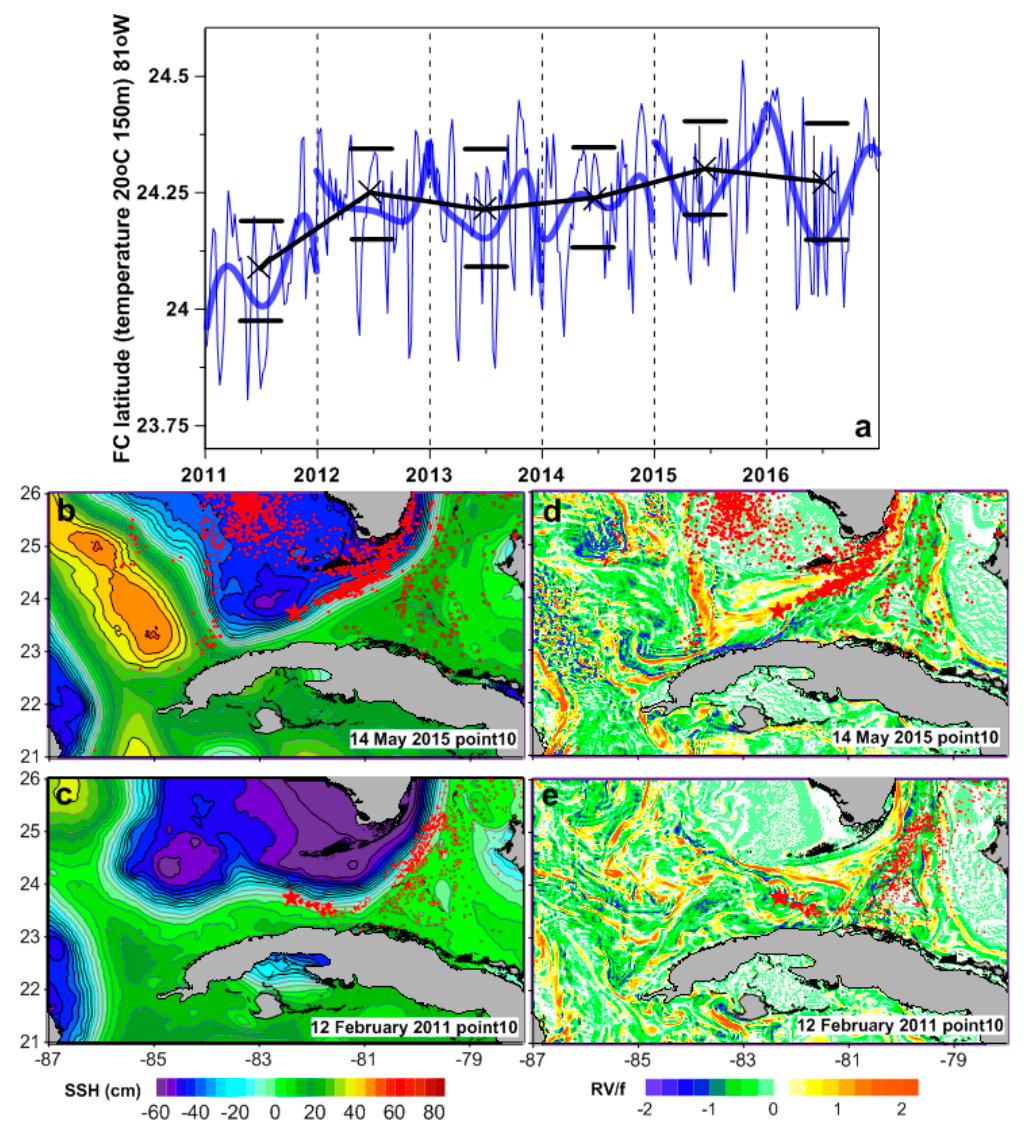
Figure 13. ( a ) Weekly position (thin blue line) of the Florida Current (FC) derived from the latitude of the 20 °C isotherm at 150 m along 81° W (Section S2; Figure 1a). The annual polynomial fit (5th order; thick blue line), the annual mean (marked with X), and the 1st and 3rd quartiles of each year are included. Sea Surface Height (SSH; cm) on ( b ) 14 May, 2015 and ( c ) 12 February, 2011. Surface Relative Vorticity (RV) normalized with the Coriolis frequency on ( d ) 14 May, 2015 and ( e ) 12 February, 2011. The locations of oil elements (red dots), released at Point 10 (red star), are also overlaid.